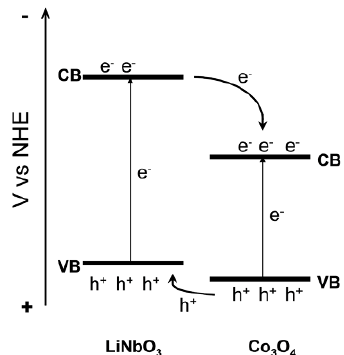
Figure 6. Proposed charge separation for Co